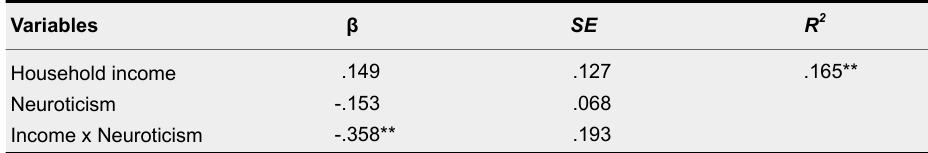
Moderating Effect of Neuroticism Between Household Income and Life Satisfaction Variables β SE R 2